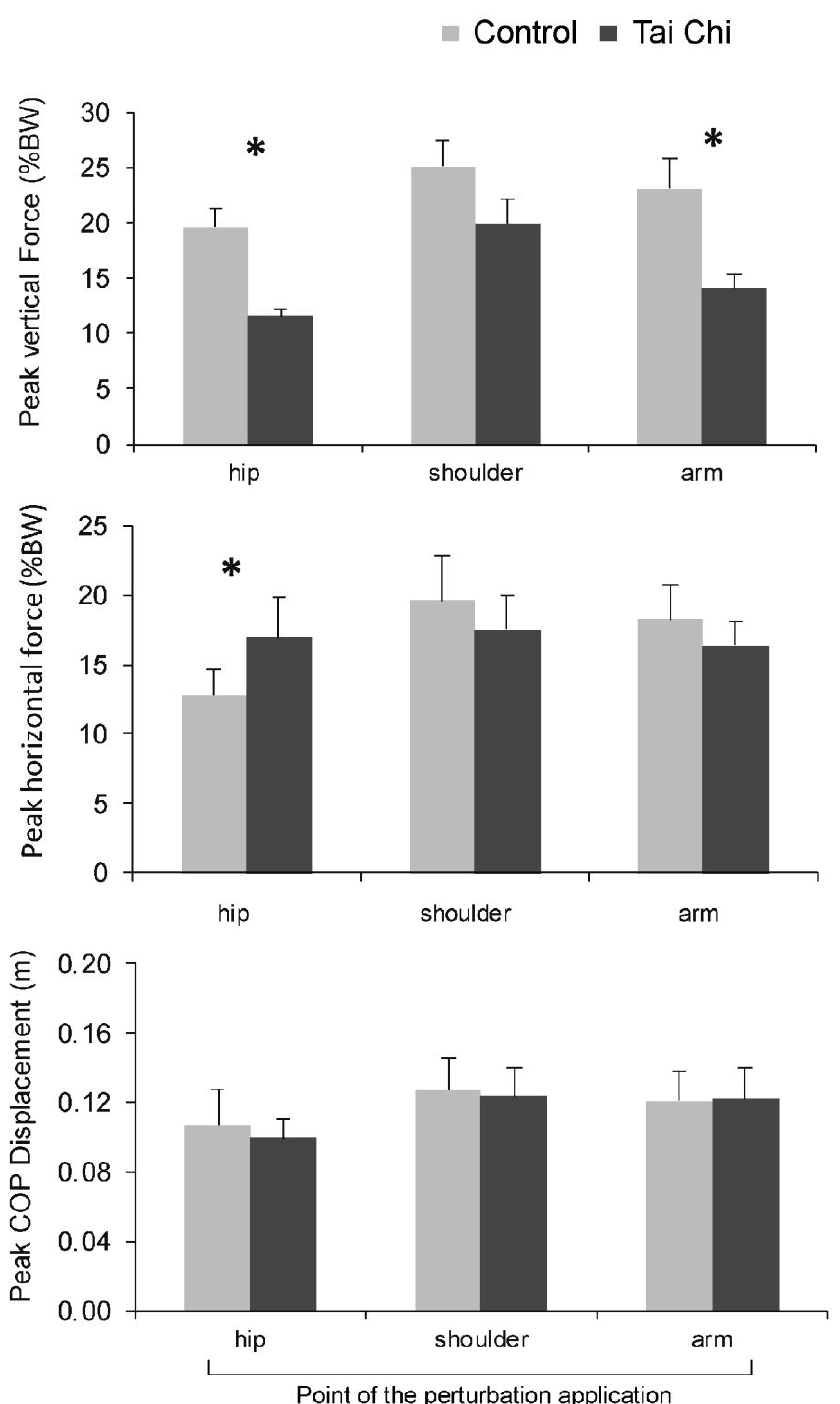
Figure 3. Peak vertical force ( top ), horizontal force ( middle ) and displacement of center of pressure ( bottom ) after sudden perturbation. * denotes statistically significant differences between the groups.